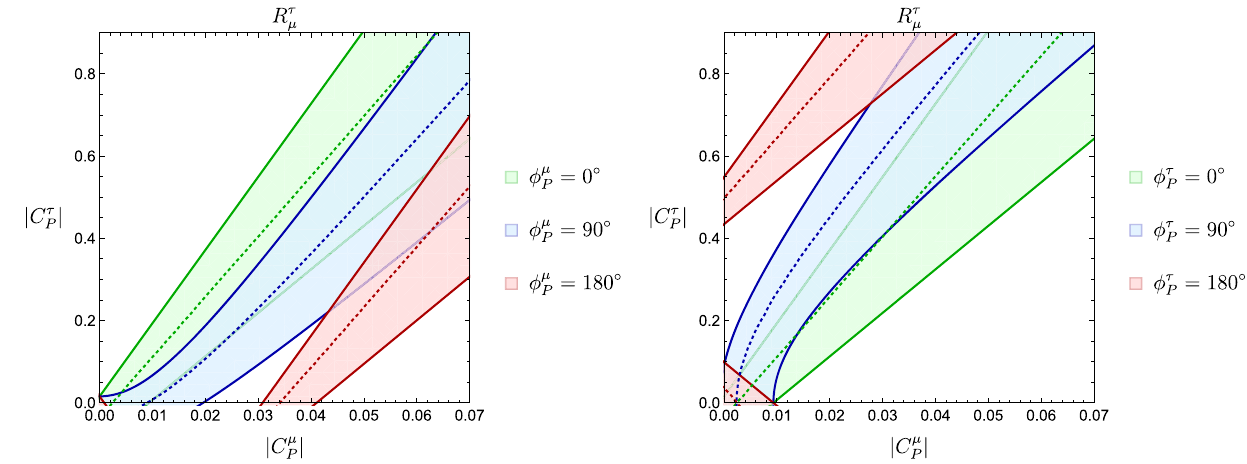
φ μ and φ τ . In the left panel, we have φ τ P P